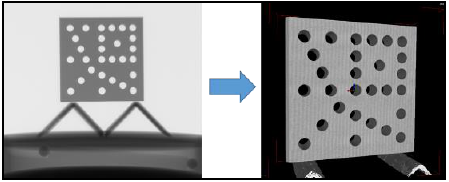
Figure 1: 2D radiograph of the holeplate (on the left) and the reconstructed volume with surface